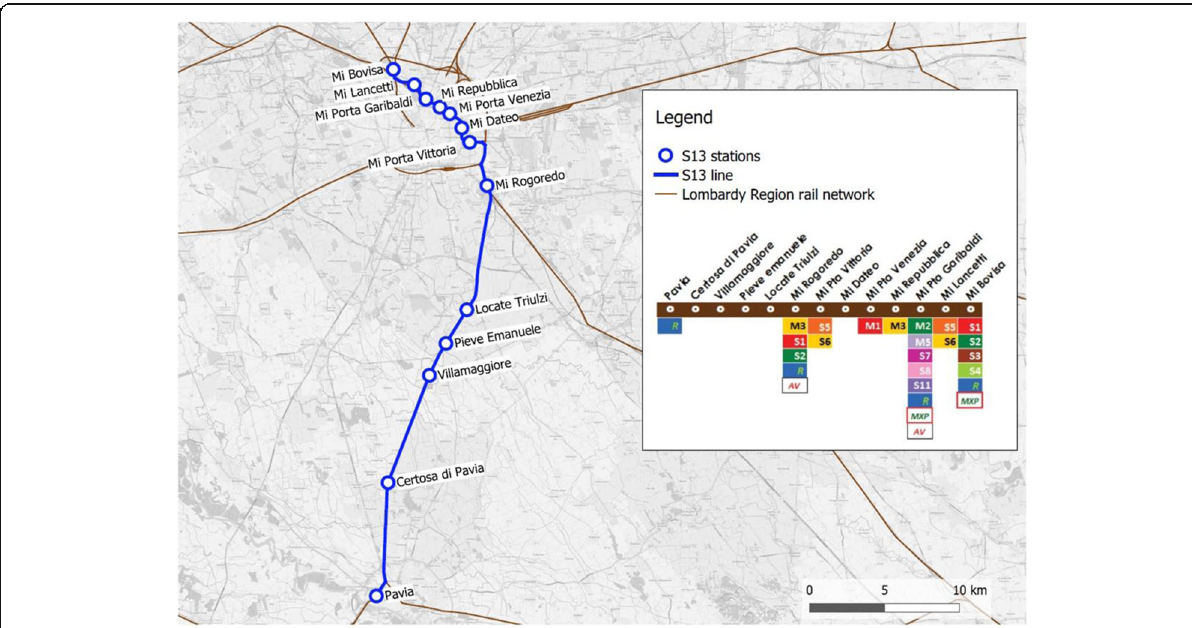
Fig. 4 The S13 suburban railway line and its interconnections with metro (M) and other suburban (S)